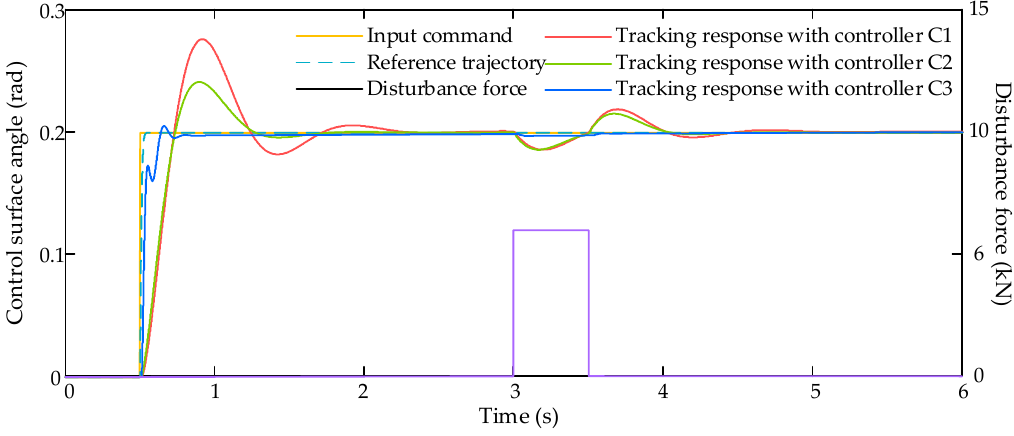
Figure 3. Tracking responses with step signal input command. Sensors 2017 , 17 , 2444